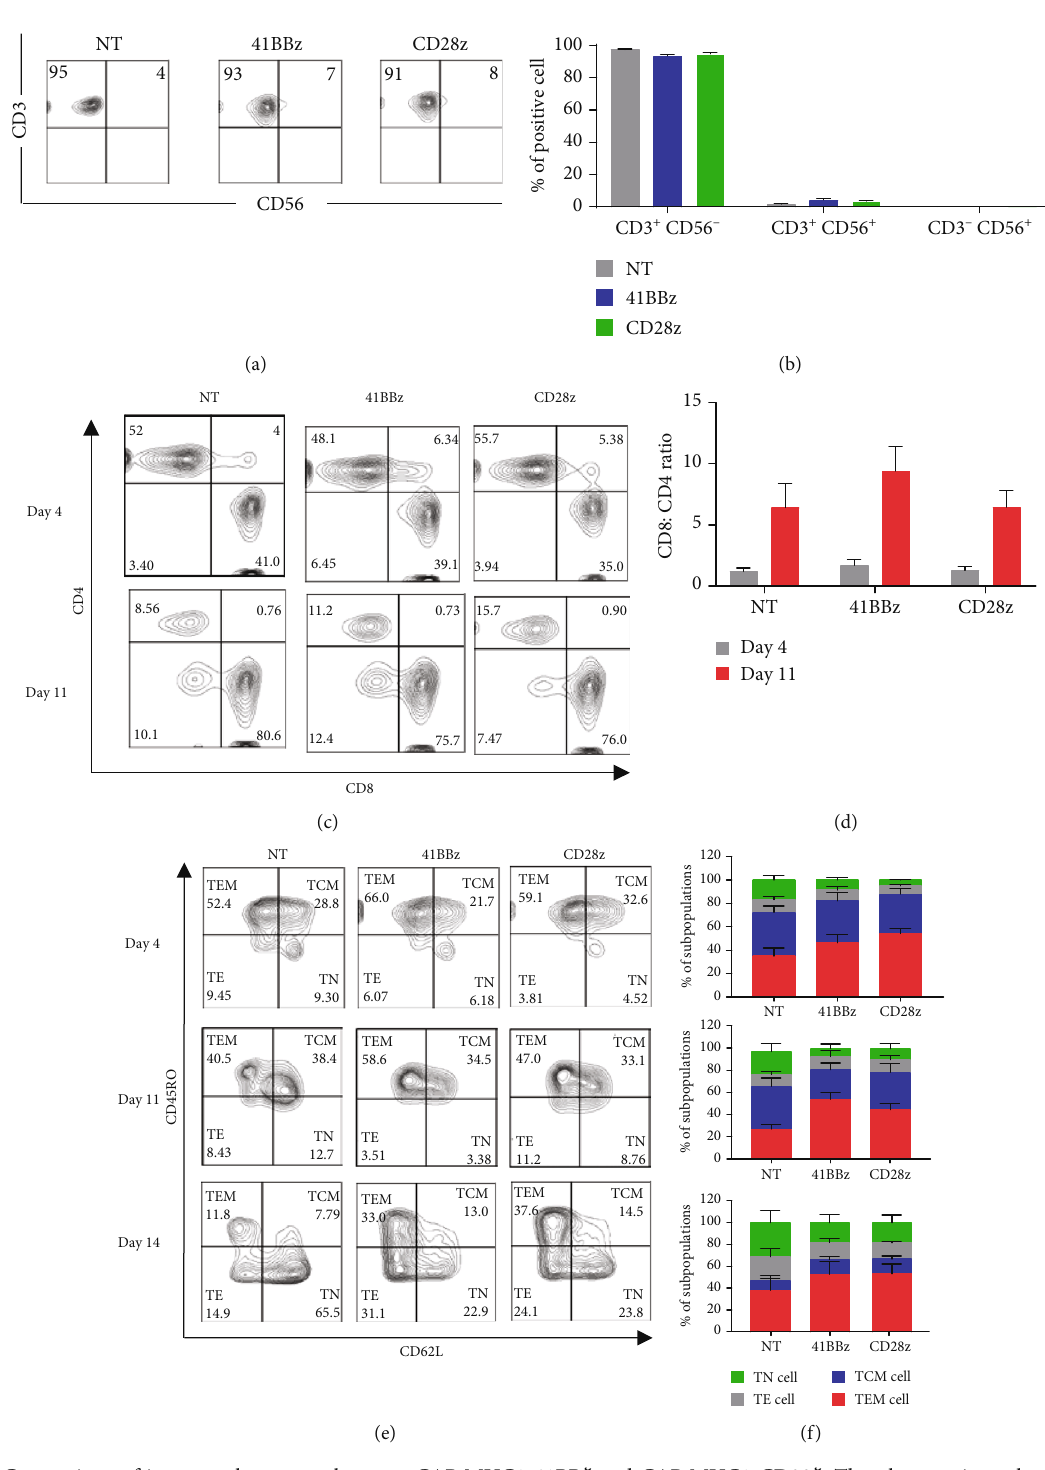
Figure 3: Comparison of immunophenotypes between CAR.MUC1-41BB ζ and CAR.MUC1-CD28 ζ . The phenotypic analyses of CAR T cells were performed on days 4, 11, and 14 after transduction. (a) Representative fl ow cytometry plot demonstrating the cell subset analyzed with fl uorochrome-conjugated anti-CD3 and anti-CD56 on day 4 after T cell transduction. (b) Bar graph represents the percentage of CD3 + T cells ( mean ± S : E : M from 8 donors). (c) Representative fl ow cytometry plot at 4 and 11 after transduction. (d) Mean percentage of CD8 + : CD4 + ratio on day 4 and day 11 after transduction is shown. Data shown are mean ± S : E : M from 6 donors. (e) Representative fl ow cytometry analysis of memory phenotype analyzed on days 4, 11, and 14 after transduction; CAR T cells were expanded in culture media containing IL-2 50 U/ml and stained with anti-CD45RO and anti-CD62L antibody (TEM: CD45RO + CD62L - , TCM: CD45RO + CD62L + , TN: CD45RO - CD62L + , and TE: CD45RO - CD62L - ). (f) The mean percentage of naïve (TN), central memory (TCM), e ff ector memory (TEM), and terminal e ff ector (TE) T cells. Data represents as mean ± S : E : M ( n = 6